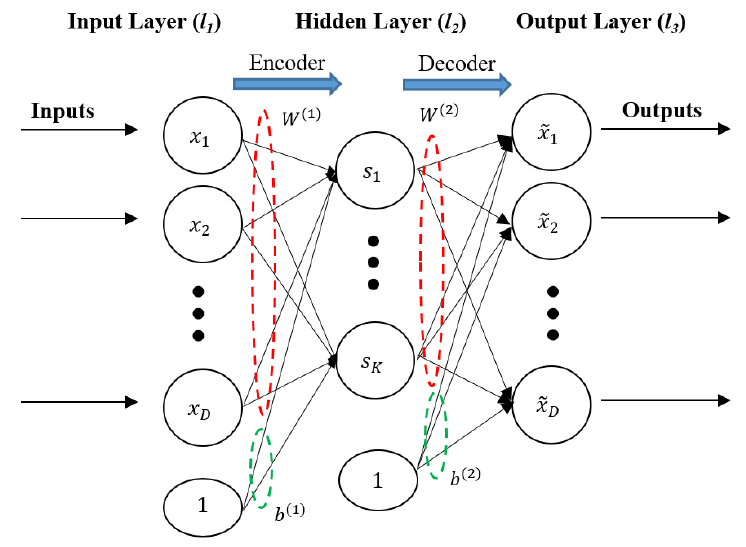
Figure 2. Sparse autoencoder structure.